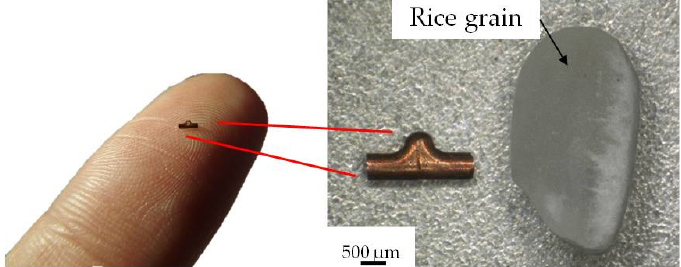
Figure 8. Micro-T-shape sample on the finger and magnified sample compared with a rice grain Figure 8. Micro ‐ T ‐ shape sample on the finger and magnified sample compared with a rice grain (C1220).